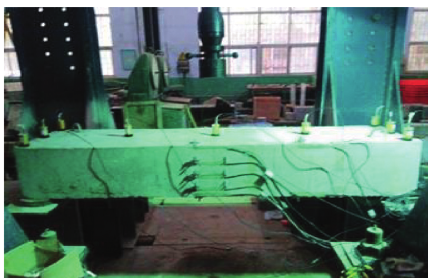
Figure 8: Measurement of fundamental frequency and